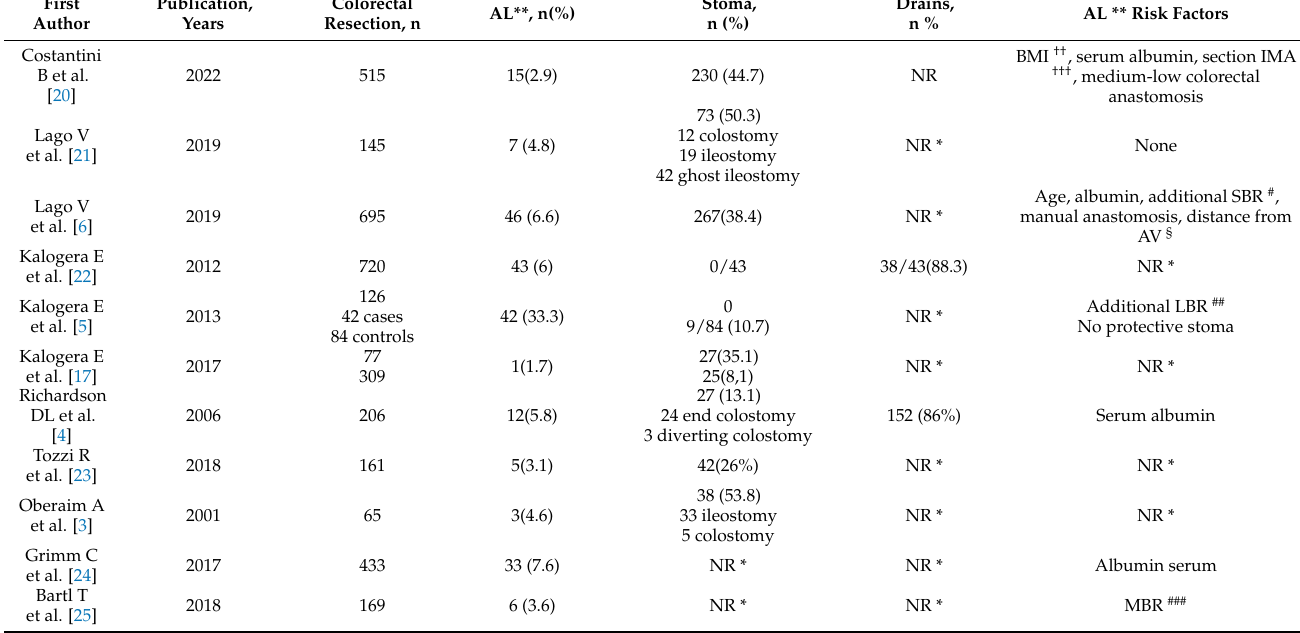
Table 7. Published articles on colorectal resection in ovarian cancer